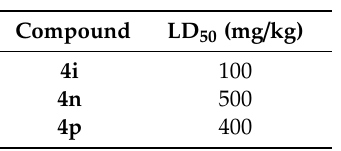
Table 3. LD 50 values of key compounds in